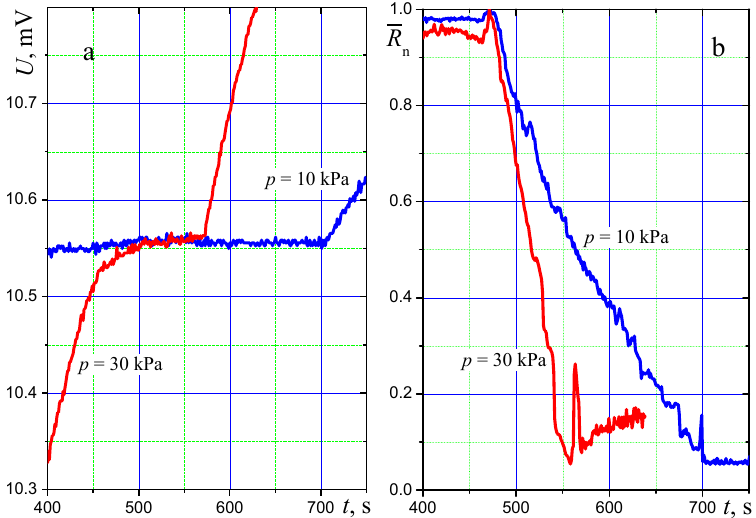
Figure 3. Time variation of ( a ) thermo-emf of thermocouple and ( b ) relative normal reflectance in the experiments with different pressures of argon.